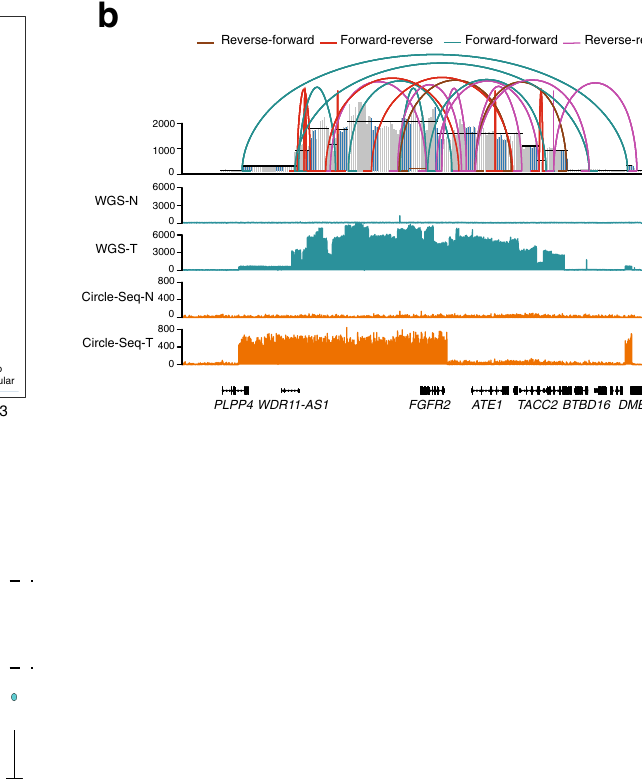
paration from the Circle-seq. Furthermore, we separated the list of circular DNA elements from Circle-seq data into ecDNA (copy number ≥ 7) and extrachromosomal circular DNA (eccDNA) (copy number < 7) following previous report 44 (Fig. 2c). We found that all circular DNA elements from Circle-Seq in the four of six cases (S21, S28, S29, and S32), where WGS did not predict focal ampli fi cations, are only from extrachromosomal circular DNA (eccDNA) (shorter than 50 kbp) (Fig. 2c). However, cir- cular DNA elements from Circle-Seq in the other two of six cases (S27 and S33), where WGS did not predict focal ampli fi cations either, contain both ecDNA and eccDNA (Fig. 2c).